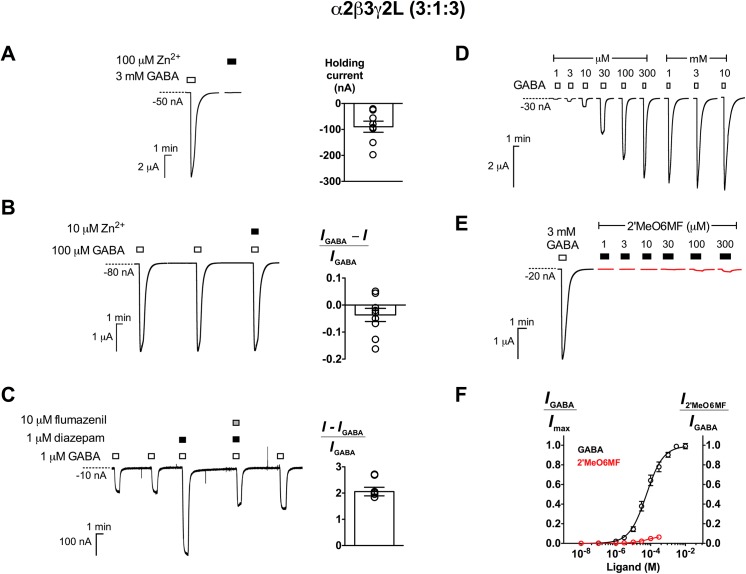
Characterisation of α2β3γ2L GABAARs expressed at a 3:1:3 injection ratio.(A) Left panel, Representative traces of α2β3γ2L (3:1:3) GABAARs responses to 3 mM GABA and 100 μM Zn2+ alone. Right panel, Mean holding current of oocytes expressing α2β3γ2L (3:1:3) GABAARs (-93 ± 19 nA; n = 8). (B) Left panel, Continuous traces demonstrating two consecutive applications of control (100 μM GABA) followed by the co-application of 10 μM Zn2+ with control. Right panel, Modulation of 100 μM GABA responses by 10 μM Zn2+ (n = 9). (C) Left panel, Continuous traces demonstrating two consecutive applications of control (1 μM GABA) followed by the co-application of 1 μM diazepam with control; 1 μM diazepam and 10 μM flumazenil with control; and control. Right panel, Potentiation by 1 μM diazepam of 1 μM GABA responses (n = 6). Representative traces demonstrating (D) GABA current responses from 1 μM to 10 mM and (E) 2’MeO6MF’s direct activation from 1 to 300 μM (red) in comparison to 3 mM GABA response. Concentration-response curves of GABA (black; n = 6) and 2’MeO6MF (red; n = 5) are shown in (F). Data are presented as mean ± SEM. Bars indicate durations of drug application. The holding current values are represented by the dotted lines.